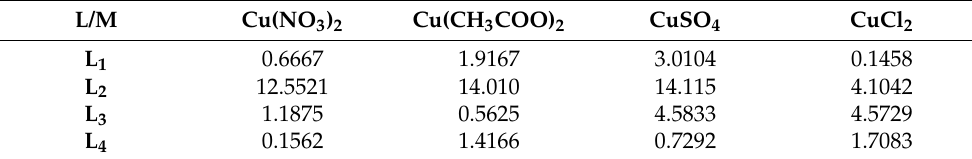
Table 1. The reaction rate of catechol oxidation in methanol ( µ mol L − 1 min − 1 ) (1L/1M). L/M Cu(NO 3 ) 2 Cu(CH 3 COO) 2 CuSO 4 CuCl 2 L 1